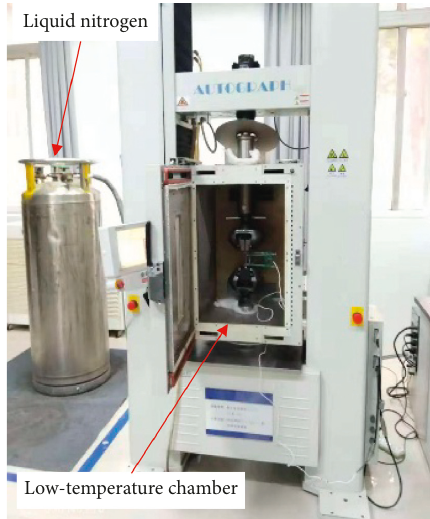
Figure 2: Universal tensile test